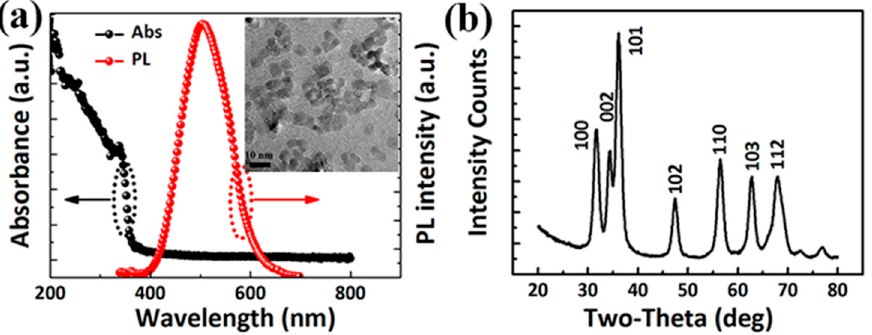
Figure 2. ( a ) Absorption and PL spectra of the ZnO NPs. Inset is the TEM image of the synthesized ZnO NPs; ( b ) XRD spectra of the ZnO NPs. Table 1. Summary of turn-on voltage, driving voltage, EQE, current efficiency, and power efficiency data of the QLED Device based on ZnO NPs dispersed in different solvents. Type of